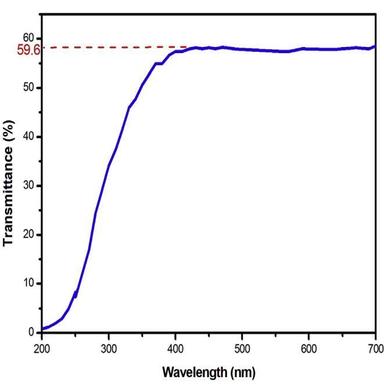
Transmission spectrum of tetrakis(thiourea)cobalt chloride crystal.